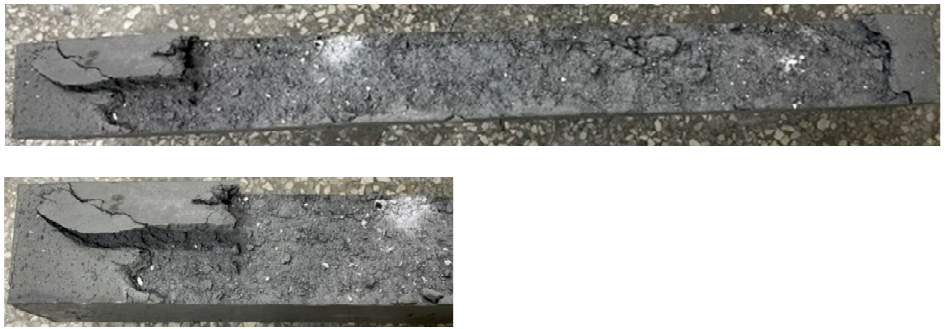
Figure 9. The spalled surface of the UHPC beam specimen after being subjected to 500 °C.